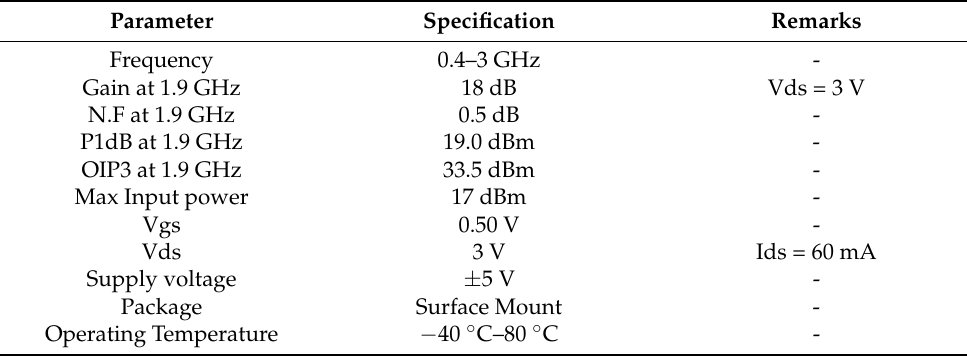
Figure 9. Circular polarized wearable active receiving Sensor with energy harvesting unit.